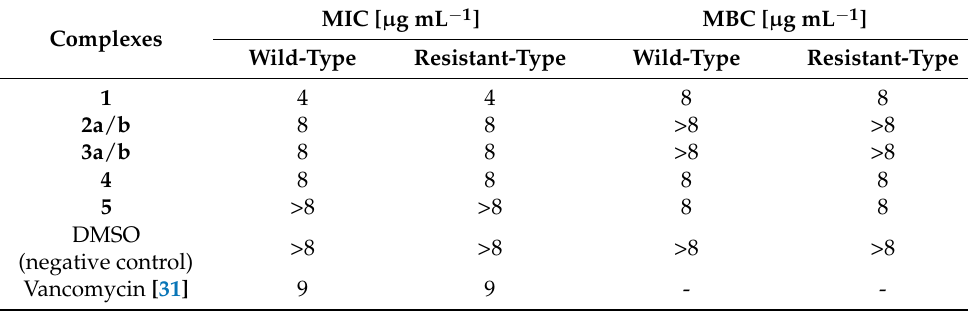
Table 1. MIC and MBC values of Re-ctz complexes against S. aureus